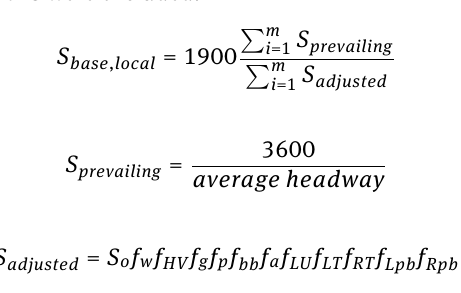
lanes, lane width (m), being in a central business district (CBD), presence of pavement marking (Marked, and Un- marked), speed limit (40, 50, 60, 70, and 80 km/hr), city (Amman, Zarqa, and Irbid), level of traffic volume (High, Medium, and Low), and area type (Urban, and Suburban). The HCM standard procedure was followed for field data collection and in computations of SFR at signalized intersections, as shown in Equations 1 to 3 [1]. The estima- tion of average headway evaluated based on video record- ings. This research focused only on the shared left- and U-turning movements (LUTM), and on the through move- ments only (THMO). The shared through with left- and right-turning movements were not considered. Also, the cycles with heavy vehicles or pedestrians or any unusual conditions were